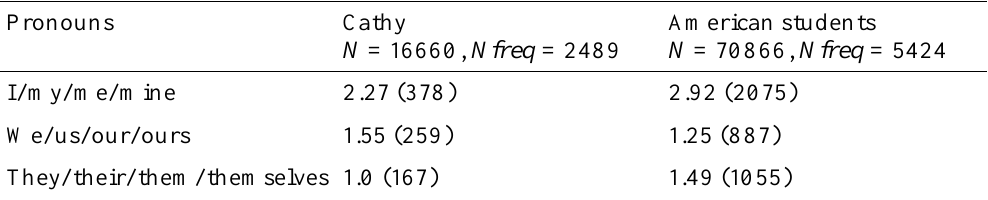
Frequency of Pronouns in Cathy’s and her American Peers’ Online Discussion Posts